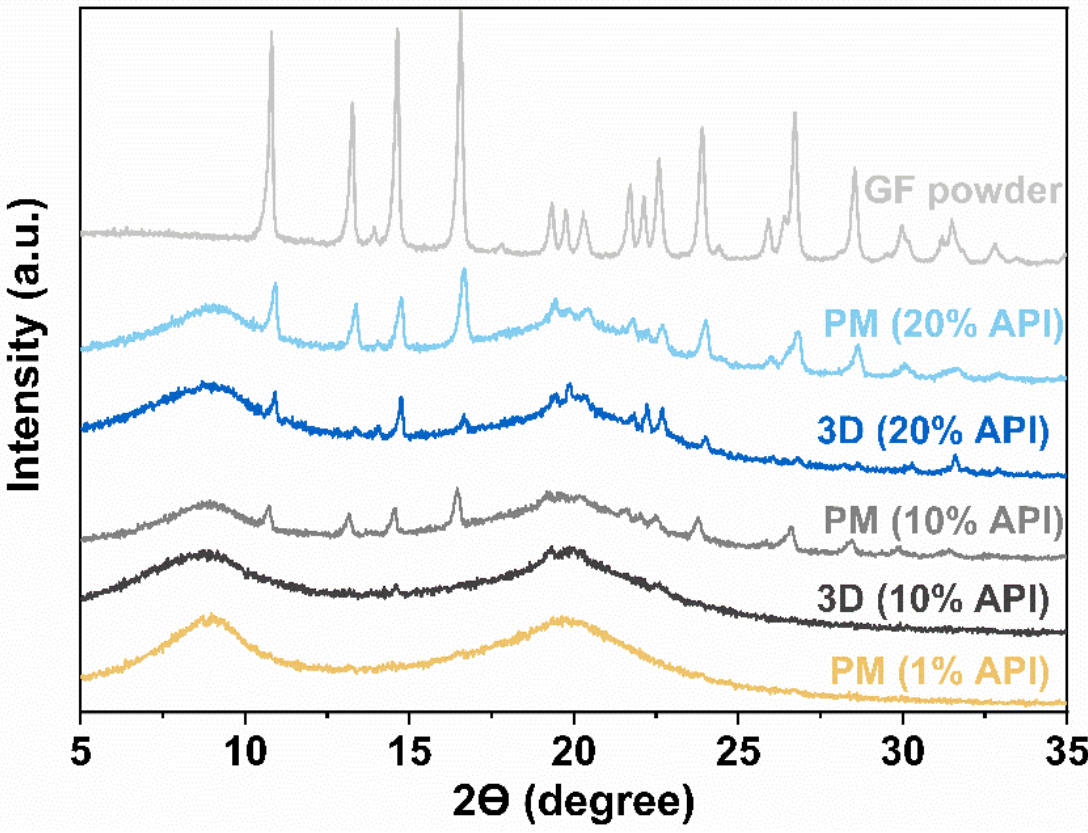
Figure 3. XRD diffractograms of GF powder, physical mixtures (PMs), and printed tablets.